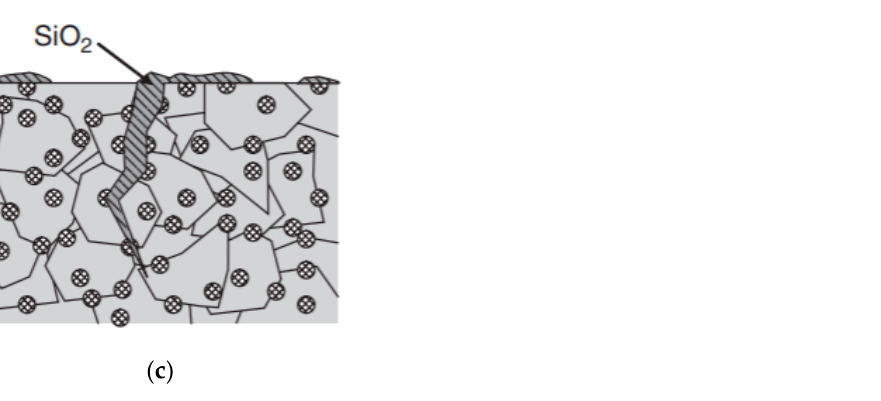
Figure 4. Crack-healing mechanism. ( a ) Before cracking; ( b ) During cracking; ( c ) After healing.